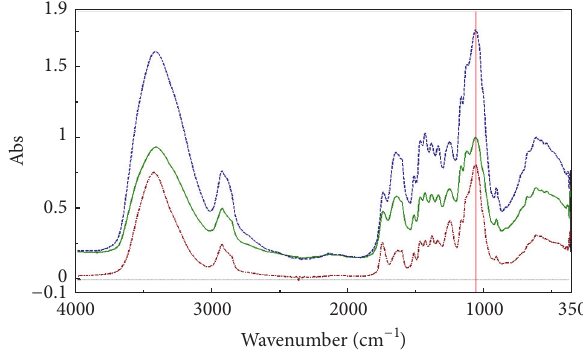
Figure 6: FTIR spectra of Imperial Gates wood species as compared to lime species: solid line, historical up wooden stand; dashed line, Imperial Gates wood; dash-dot line, lime wood standard.